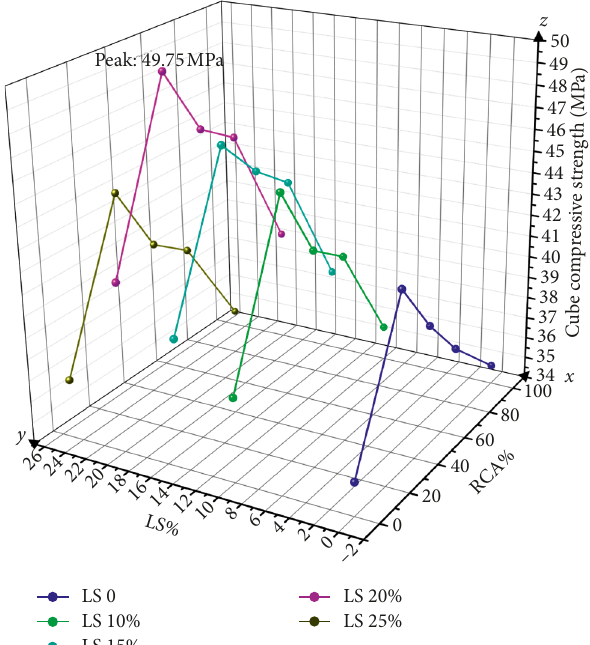
Figure 2: The effect of RCA and LS on the cube compressive strength.